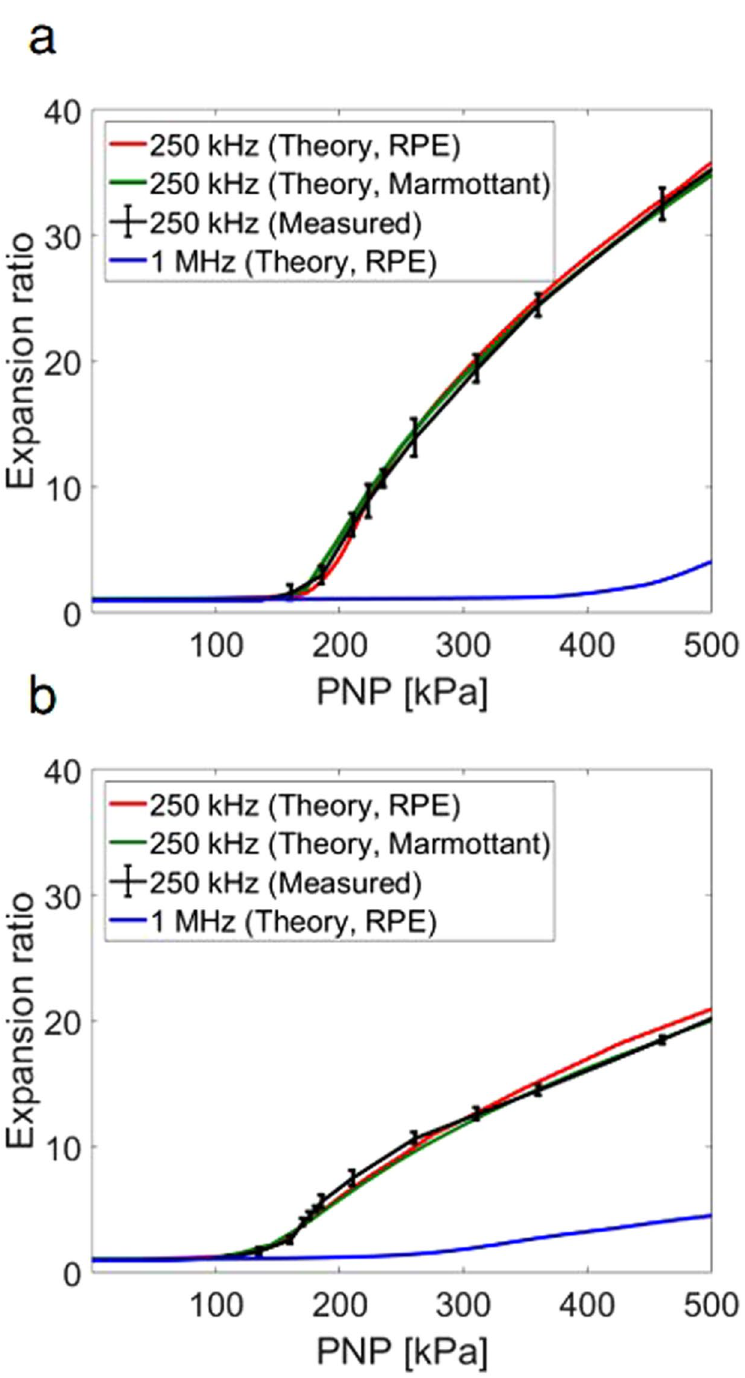
Figure 5. Ultra high-speed camera experimental observations and theoretical predictions for MB expansion ratio using the modified Rayleigh-Plesset Equation (RPE) and the Marmottant model, as a function of peak negative pressure (PNP) for a transmission center frequency of 250 kHz and 1 MHz. ( a ) for MBs with radii of 0.75 μ m. ( b ) for MBs with radii of 1.5 μ